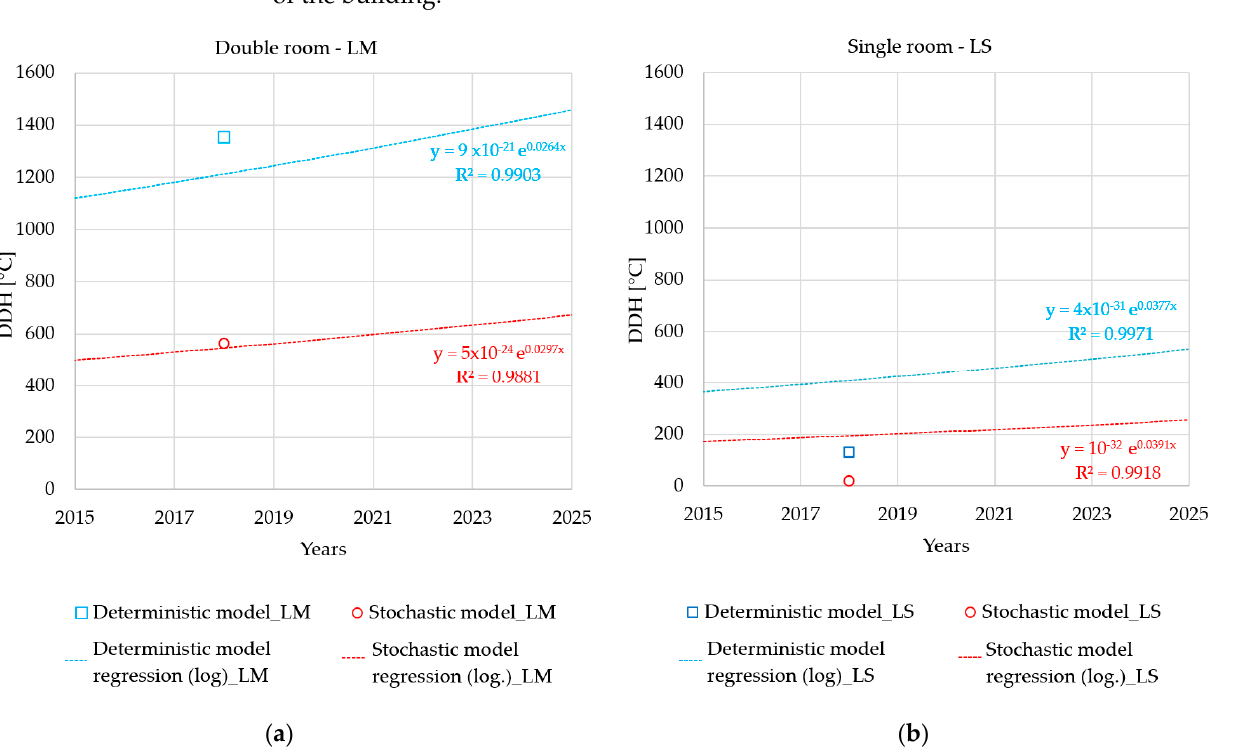
Figure 11. Predicted vs. real DDH by the adoption of the rule-based and stochastic models for the LM room ( a ) and LS room ( b ).